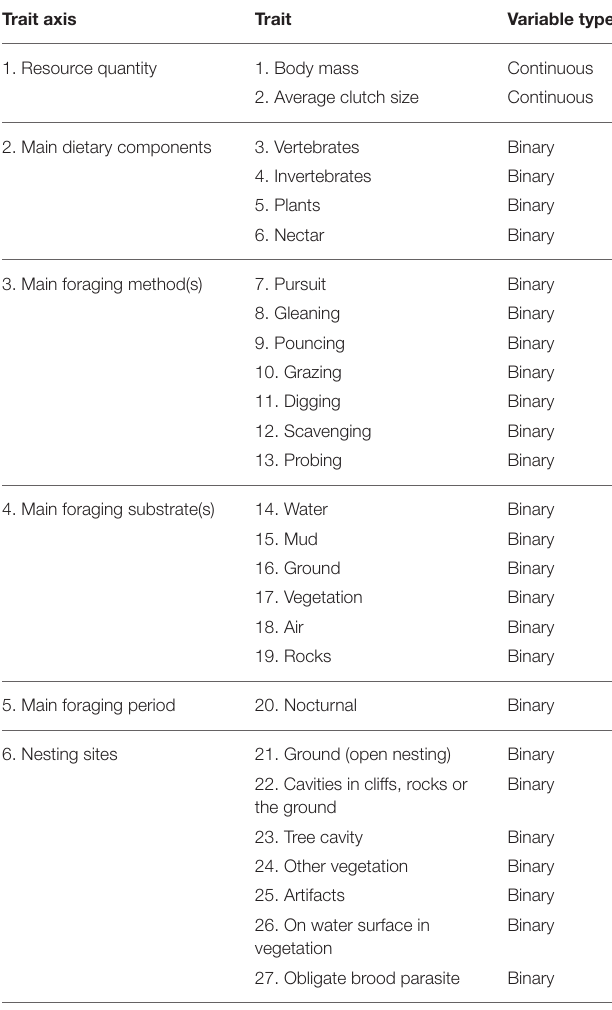
TABLE 1 | The 6 trait axes and 27 specific traits used to characterize avian functional diversity. Trait axis Trait Variable